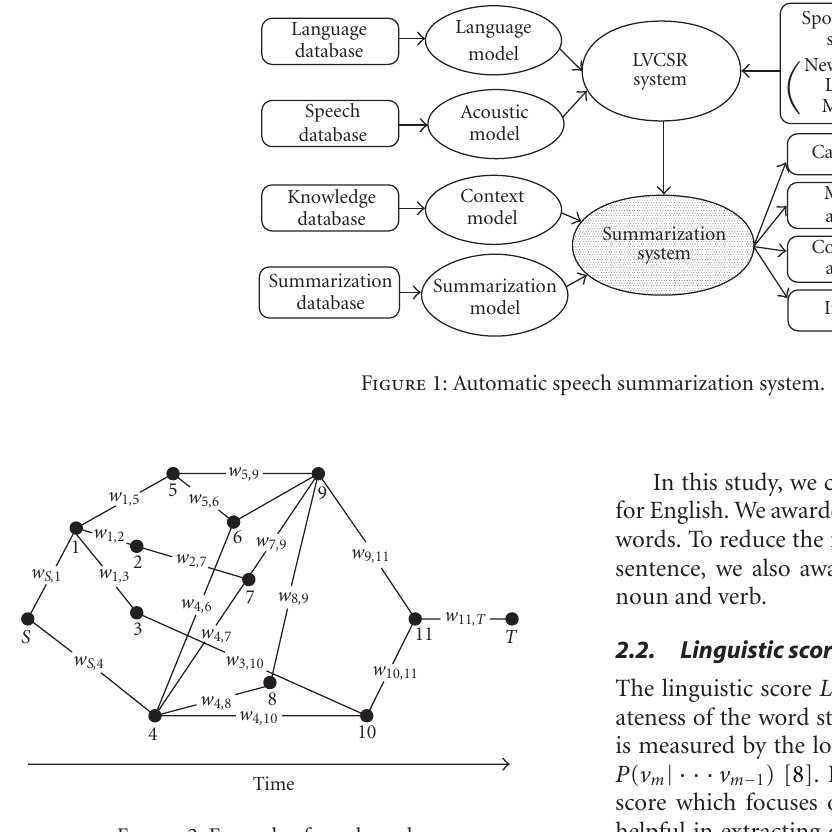
Figure 2: Example of word